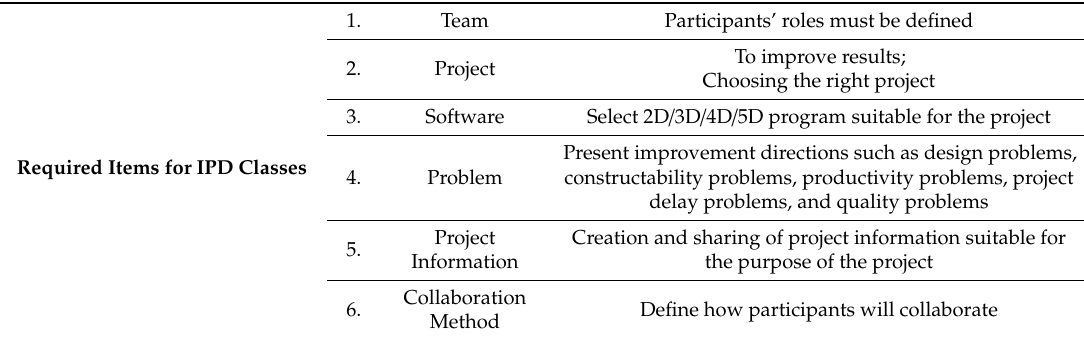
Table 3. Configuration items for IPD collaboration